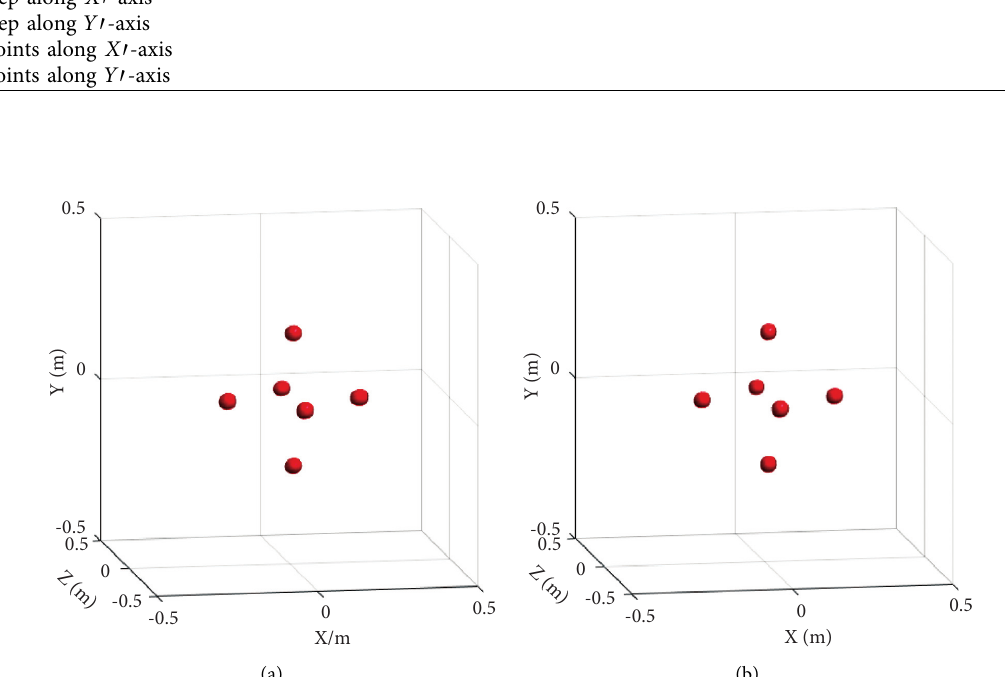
Figure 5: Reconstructed 3D images of point targets: (a) presented algorithm in this paper; (b)